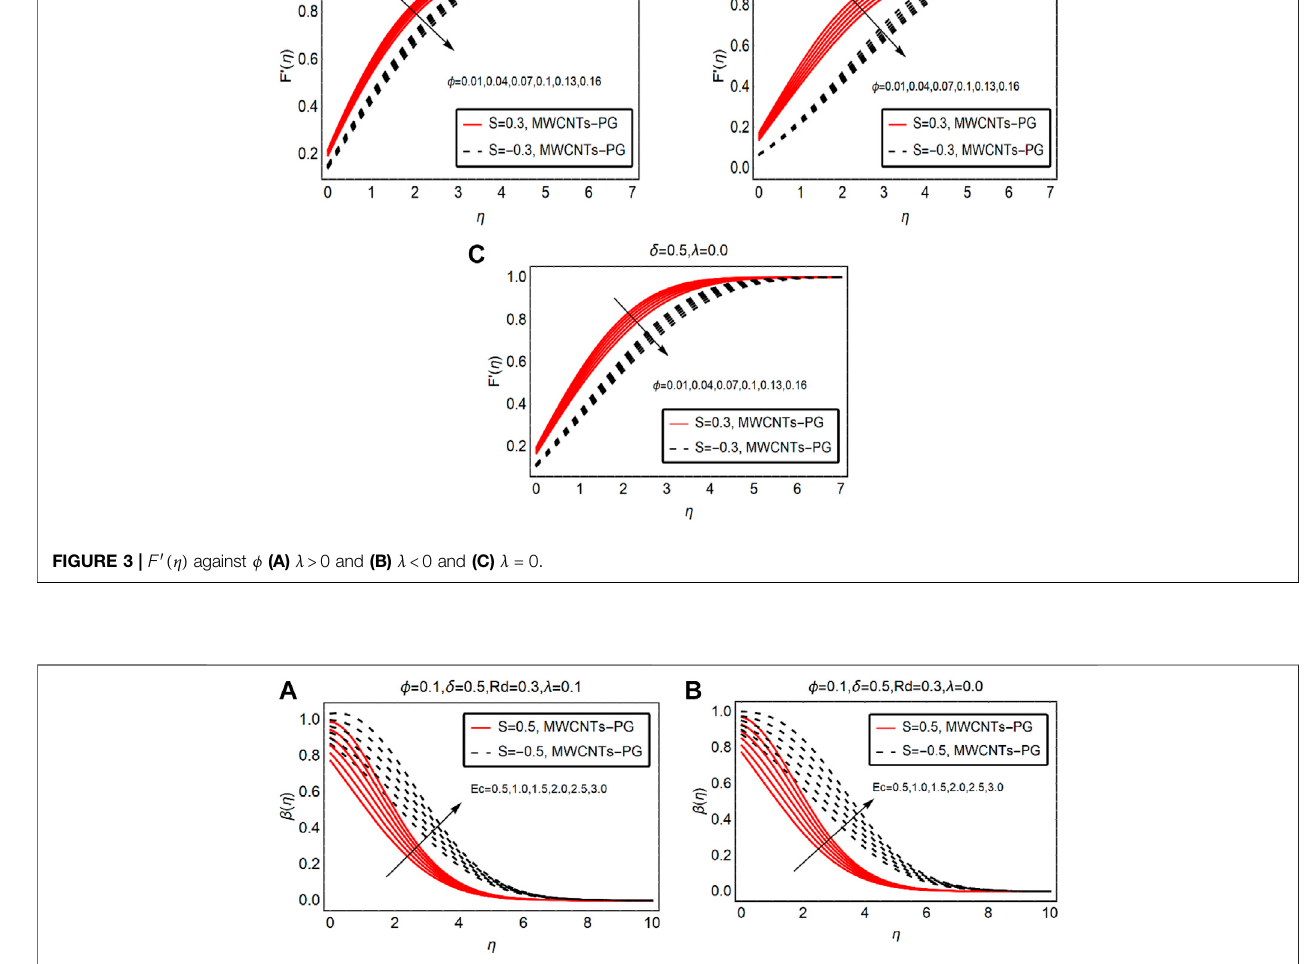
FIGURE 4 | β ( η ) against Ec (A) λ > 0 and (B) λ (cid:2) 0.